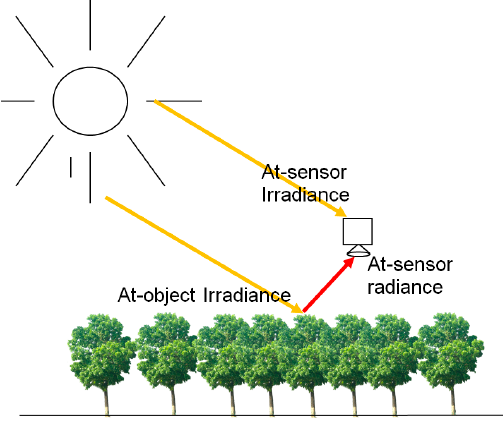
Figure 1. Principle of the direct reflectance measurement from drone.